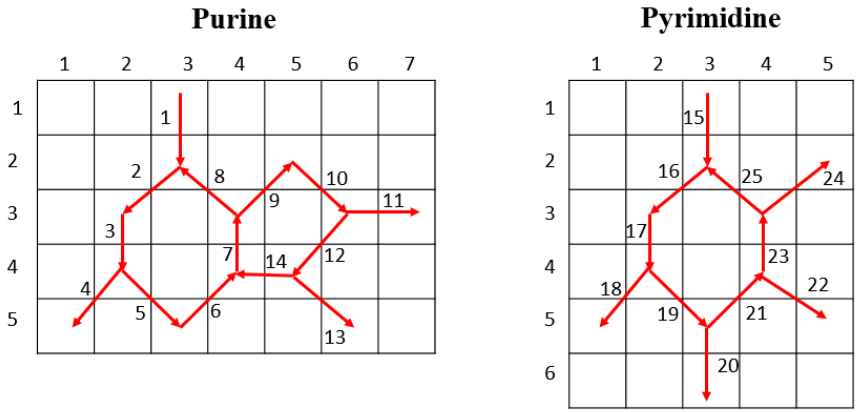
Figure 2. Directed cyclic graphical representations of purine (fused six- and five-membered ring conformation) and pyrimidine (six-membered ring). Individual directed paths are constructed using red arrows, which are enumerated. The initial and final points of each arrow represent the first and second parameters of the signum function for bit generation, respectively. With both structures combined, 25 bits (total number of directed paths) can be generated using 5 × 7 and 6 × 5 sized matrices (see text).